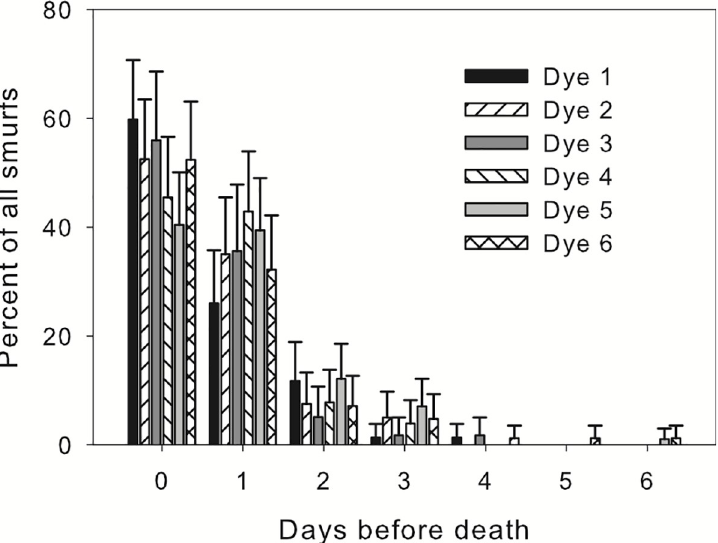
Fig 4. Timing of SMURF appearance using only flies that satisfied our criteria for being a Smurf. Most flies appeared to be Smurfs on the day they are found dead or 1 day before death. Of the D . melanogaster that became a Smurf, a majority of them did so on the day of their death or one day before. Bars are simultaneous 95% confidence intervals. Dye 1: SPS Alfachem Blue, Dye 2: Sigma Aldrich, Dye 3: Spectrum Blue, Dye 4: Flavors and Color Blue, Dye 5: Chemistry Connection Blue, and Dye 6: Electric Blue.